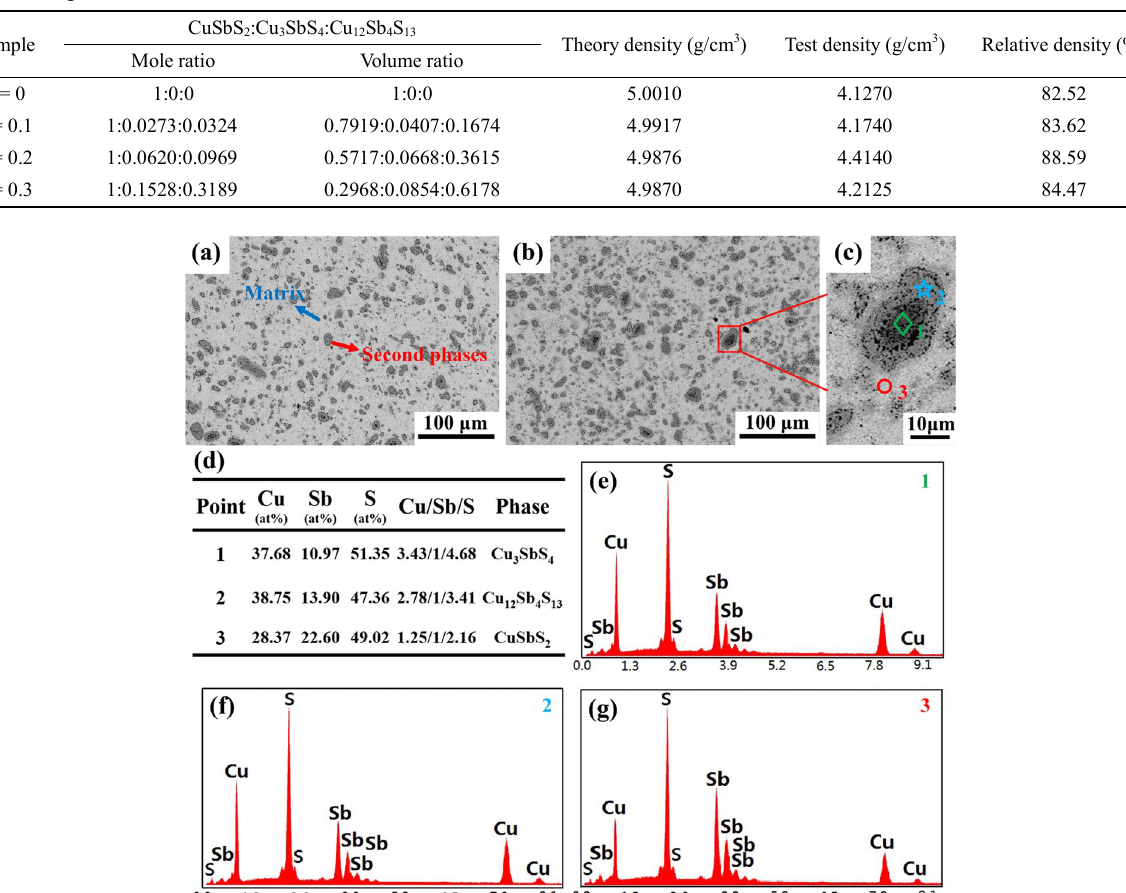
Fig. 3 XRD patterns of the bulk samples with the mole ratio of (1– x )CuSbS 2 – x Cu 1.8 S ( x = 0, 0.1, 0.2, 0.3) at 2 θ range of (a) 28.2°–29.0°, (b) 47.5°–48.1°, (c) 56.4°–57.1°, (d) 29.4°–30.2°, (e) 34.5°–34.9°, and (f) 49.6°–50.2°. Table 1 Actual ratio of CuSbS 2 :Cu 3 SbS 4 :Cu 12 Sb 4 S 13 for the bulk samples with the mole ratio of (1– x )CuSbS 2 – x Cu 1.8 S at room temperature